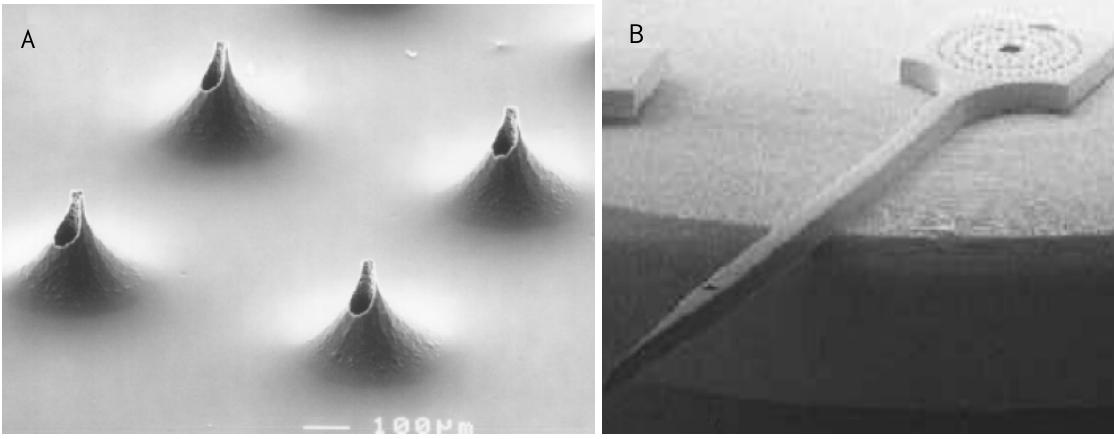
Figure 4 . Out-of-plane (a) and in-plane (b) microneedles formed by etching silicon